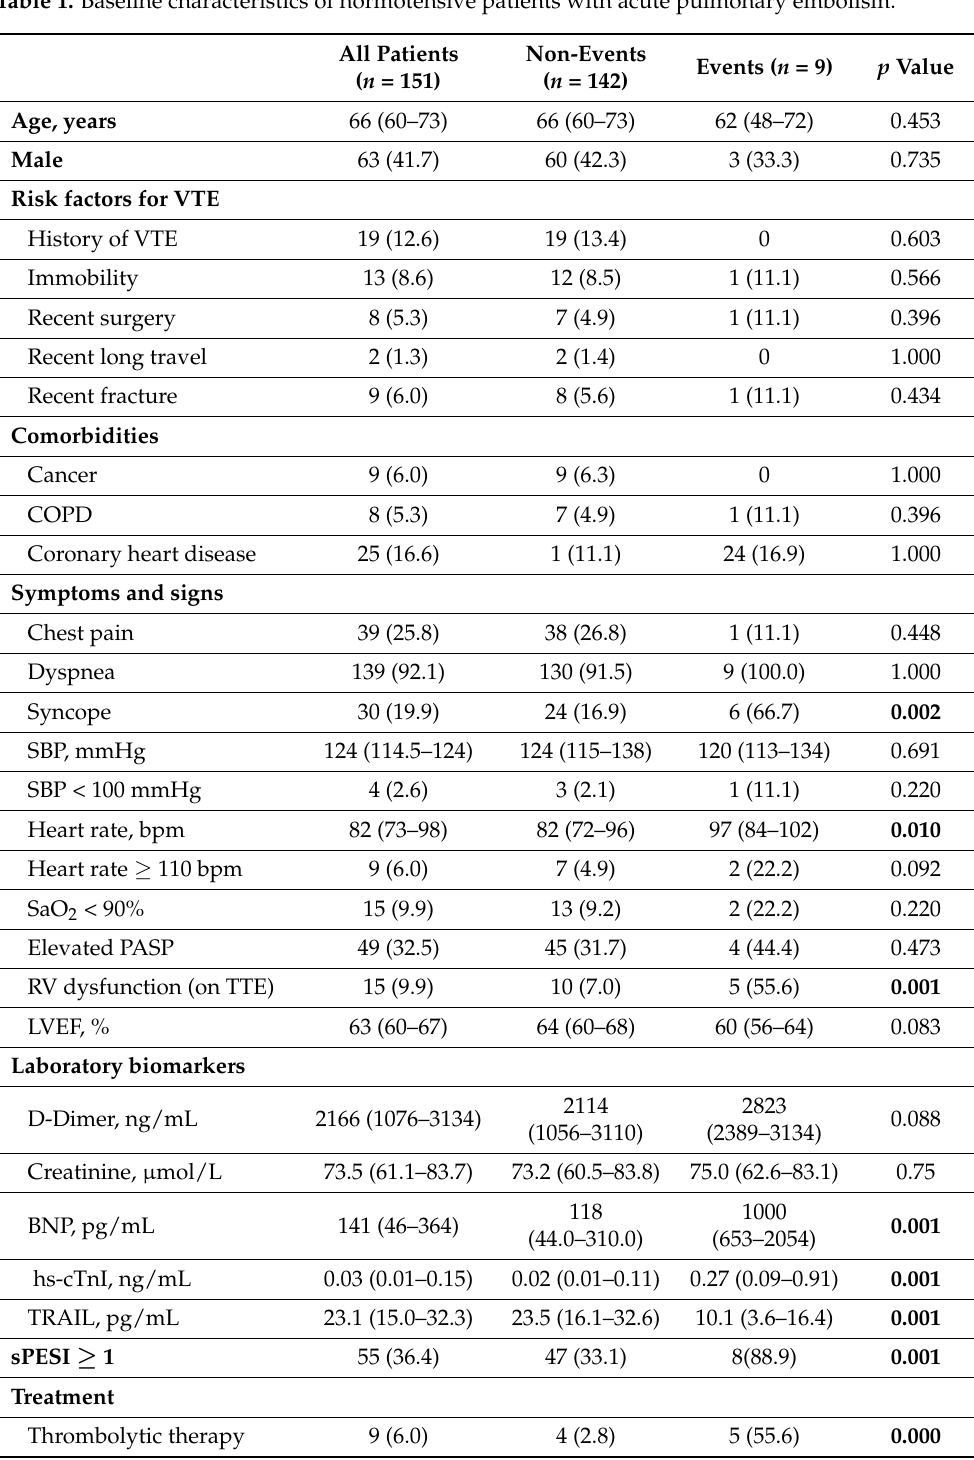
Table 1. Baseline characteristics of normotensive patients with acute pulmonary